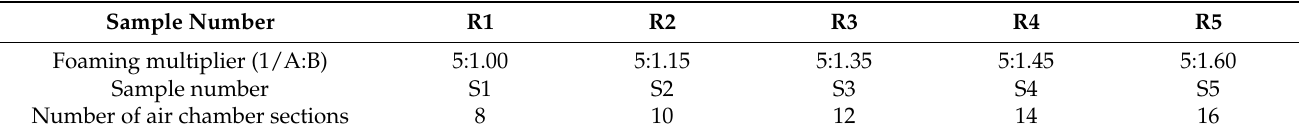
Table 2. Actuators with different materials and construction parameters.